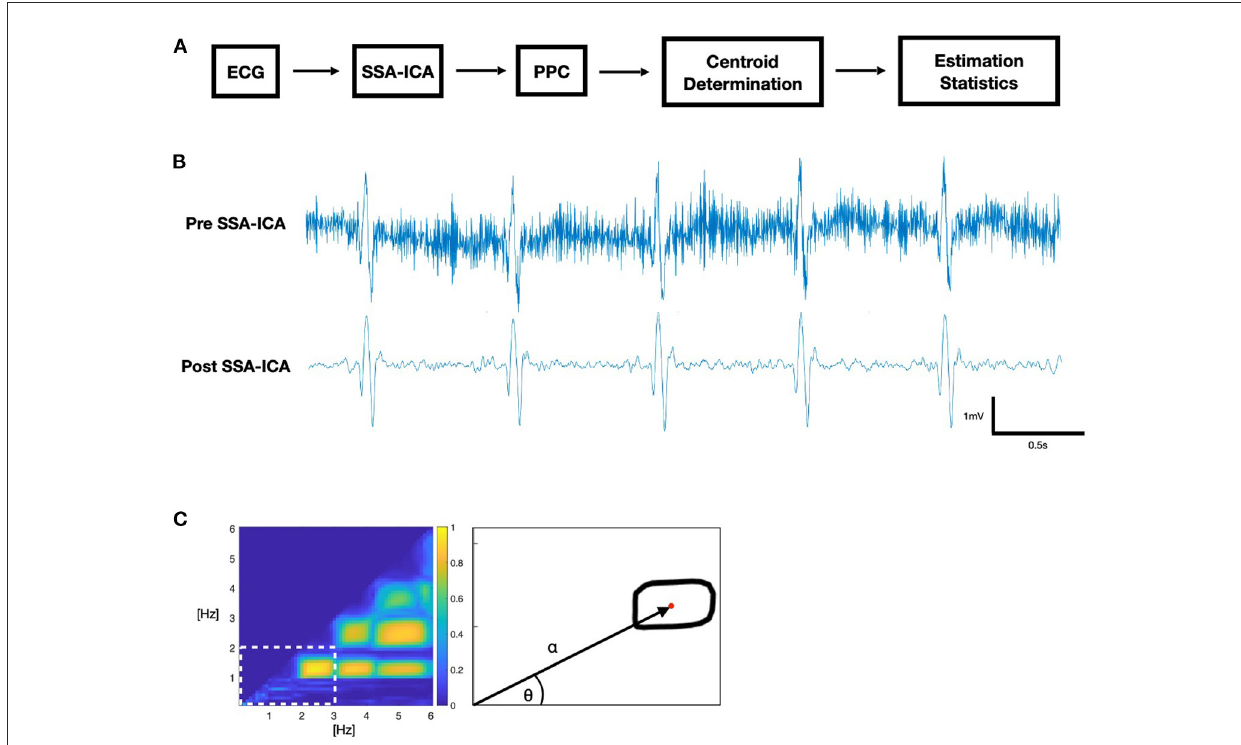
FIGURE1 (A) Block diagram of ECG data analysis. (B) Sample ictal ECG. (C) Phase-phase comodulogram (PPC) feature extraction: polar coordinates alpha and theta of the contour centroid